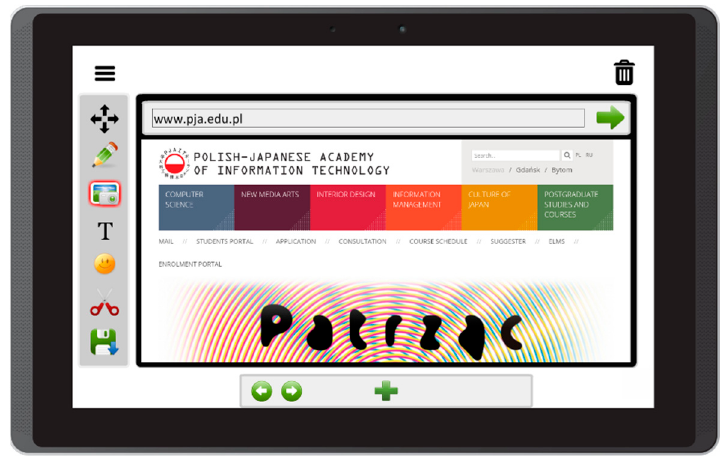
Figure 7. Accessing websites in a web browser in Aphasia Create (screenshot from an Android tablet).